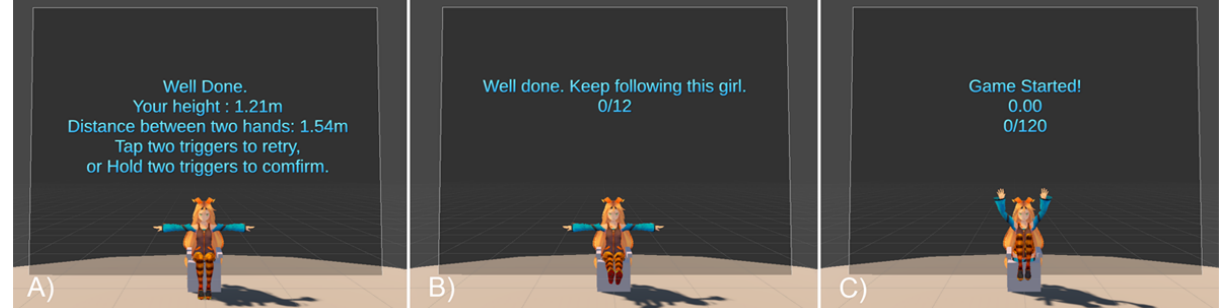
Figure 1. (A) Calibration, (B) training, and (C) game phases for the seated version; the process for the standing version is the same, except the instructor is standing instead of